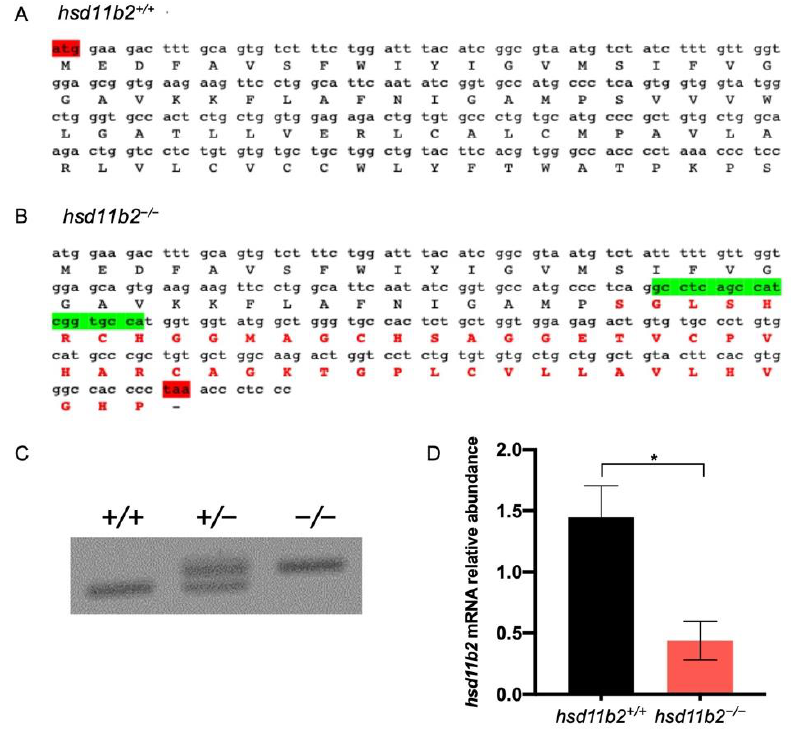
Figure 1. Generation of hsd11b2 mutant zebrafish line. ( A ) Partial (from the start codon) nucleotide and aminoacidic sequence of hsd11b2 in WT animals. ( B ) Partial (from the start codon) nucleotide and aminoacidic sequence of hsd11b2 in mutant animals showing in green the 19-nt insertion. ( C ) Representative picture of hsd11b2 +/+ , hsd11b2 +/− and hsd11b2 −/− genotyping in 2% agarose gel. ( D ) RT-qPCR of hsd11b2 transcripts in hsd11b2 +/+ and hsd11b2 −/− 5-dpf larvae. n = 4 independent biological replicas. Mean ± SEM. Statistical significance was determined by Student’s t -test. * p < 0.05. The significant downregulation of hsd11b2 expression in hsd11b2 −/− compared to hsd11b2 +/+ siblings should rely on non-sense mediated mRNA decay (NMD) mechanisms that are usually triggered in mutant lines [31]. The genetic abrogation of the Hsd11b2 activity determines a slight but significant increase of body length at 6 dpf. However, this effect cannot be detected at 15 dpf or at 3 months post fertilization (mpf) (Figure 2). We did not see any differences in eye diameter nor eye area between hsd11b2 +/+ and hsd11b2 − / − siblings. Mutants do not show any abrupt phenotypes and they are completely indistinguishable from WT siblings from a morphological point of view both at larval and adult stage. On the contrary, the absence of a functional Hsd11b2 enzyme affects the survival of larvae since we observed a significant reduction in the % survival of homozygous mutants (11%) compared to the expected one (25%) at 60 dpf. At the same time, we could not see significant differences between observed and expected percentages of hsd11b2 +/+ and hsd11b2 +/ − animals (Figure